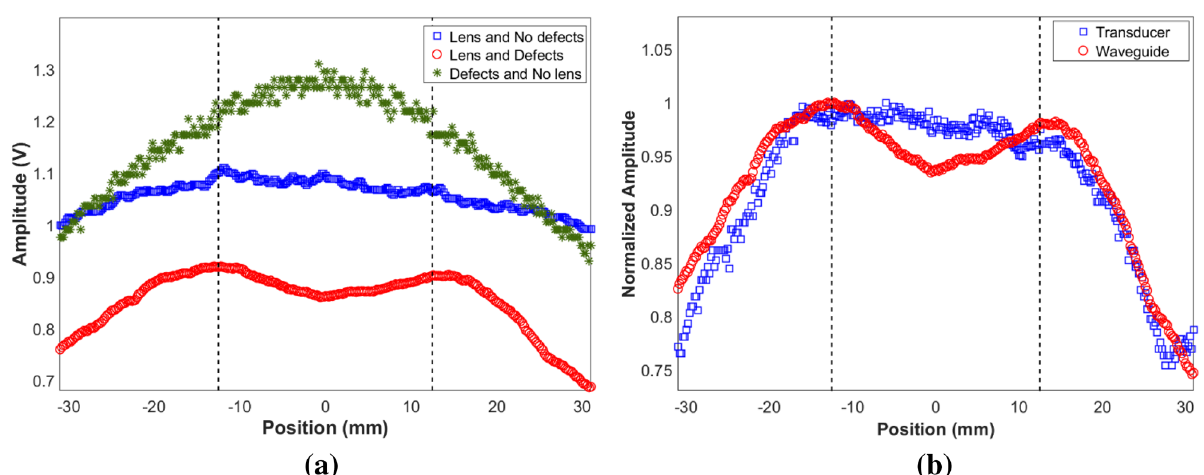
Figure 5. Experimental results from 5X hyperlens showing the magnified image for defects separated by a subwavelength distance of 5 mm (λ/3). ( a ) Results obtained using waveguide receiver. ( b ) Comparison of results obtained using waveguide receiver and commercial transducer. Since the amplitudes of signals received in both cases differ by nearly 20 dB for the same settings, the results are presented on a normalized scale. The dotted lines show the expected locations of the defects in the magnified